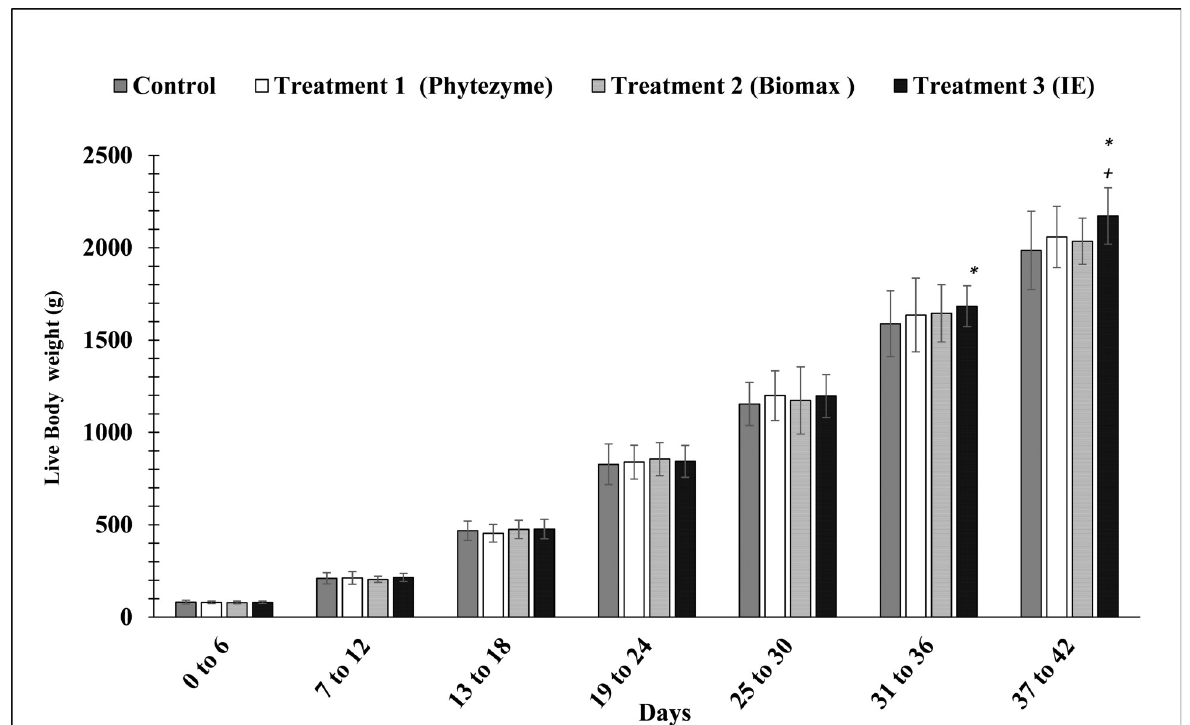
Fig 1. Effects of enzymes’ treatment on body weight gain and growth in birds. Values represent mean ± (SD). Significant differences by Tukey’s test: � p < 0.01 from Control group; +p < 0.01 from the treatment group (T1 and T2).